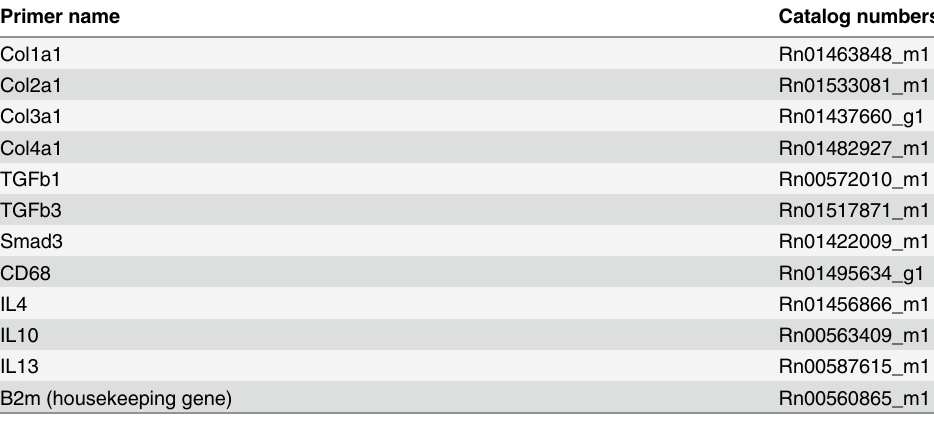
Table 1. List of Primers utilized for TaqMan quantitative real time PCR. Primer names and catalog num- bers are presented according to the vendor Life Technologies Corporation (Carlsbad, CA,